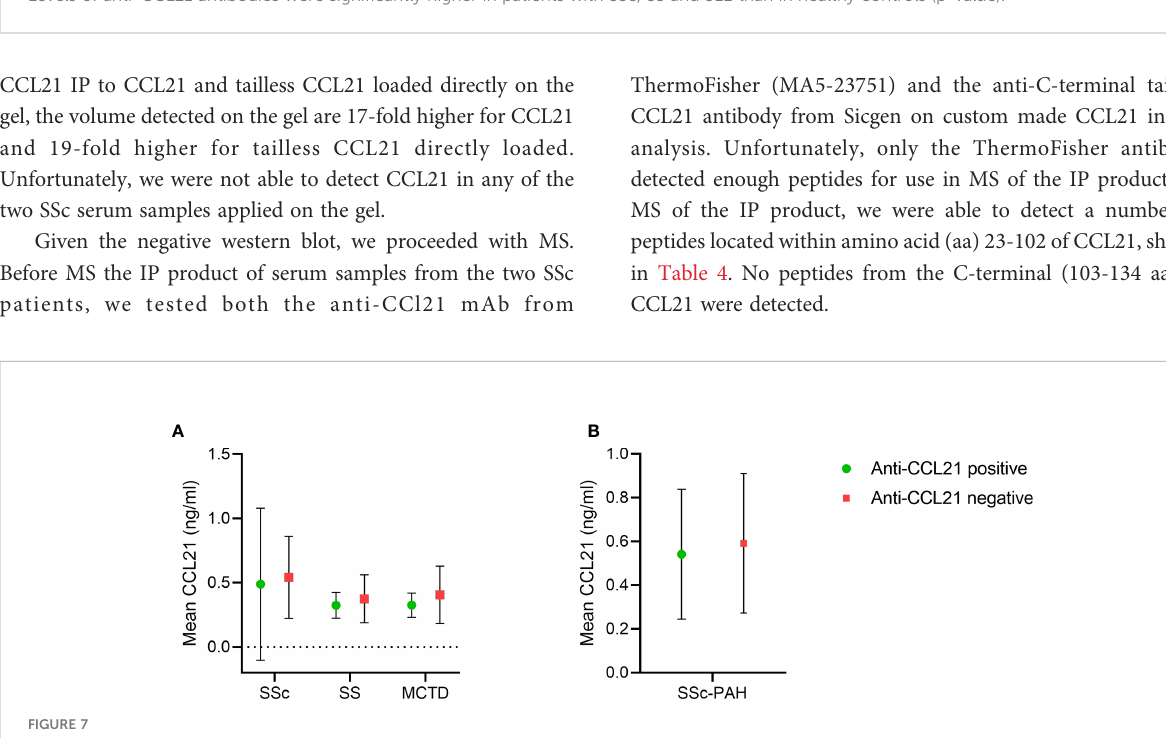
FIGURE 6 Serum anti-CCL21 antibody level in healthy controls and patients with different systemic connective tissue diseases. The dots in healthy controls (green), Systemic sclerosis (SSc; pink), primary Sjøgren syndrome (SS; purple), Systemic lupus erythematosus (SLE; blue) and Mixed connective tissue disease (MCTD; orange) shows the level of anti-CCL21 in the different patients. The dotted line represents the cut off value for considering the patients positive or negative for anti-CCL21, in which the patients above the dotted line are positive for anti-CCL21 antibodies. Levels of anti-CCL21 antibodies were signi fi cantly higher in patients with SSc, SS and SLE than in healthy controls